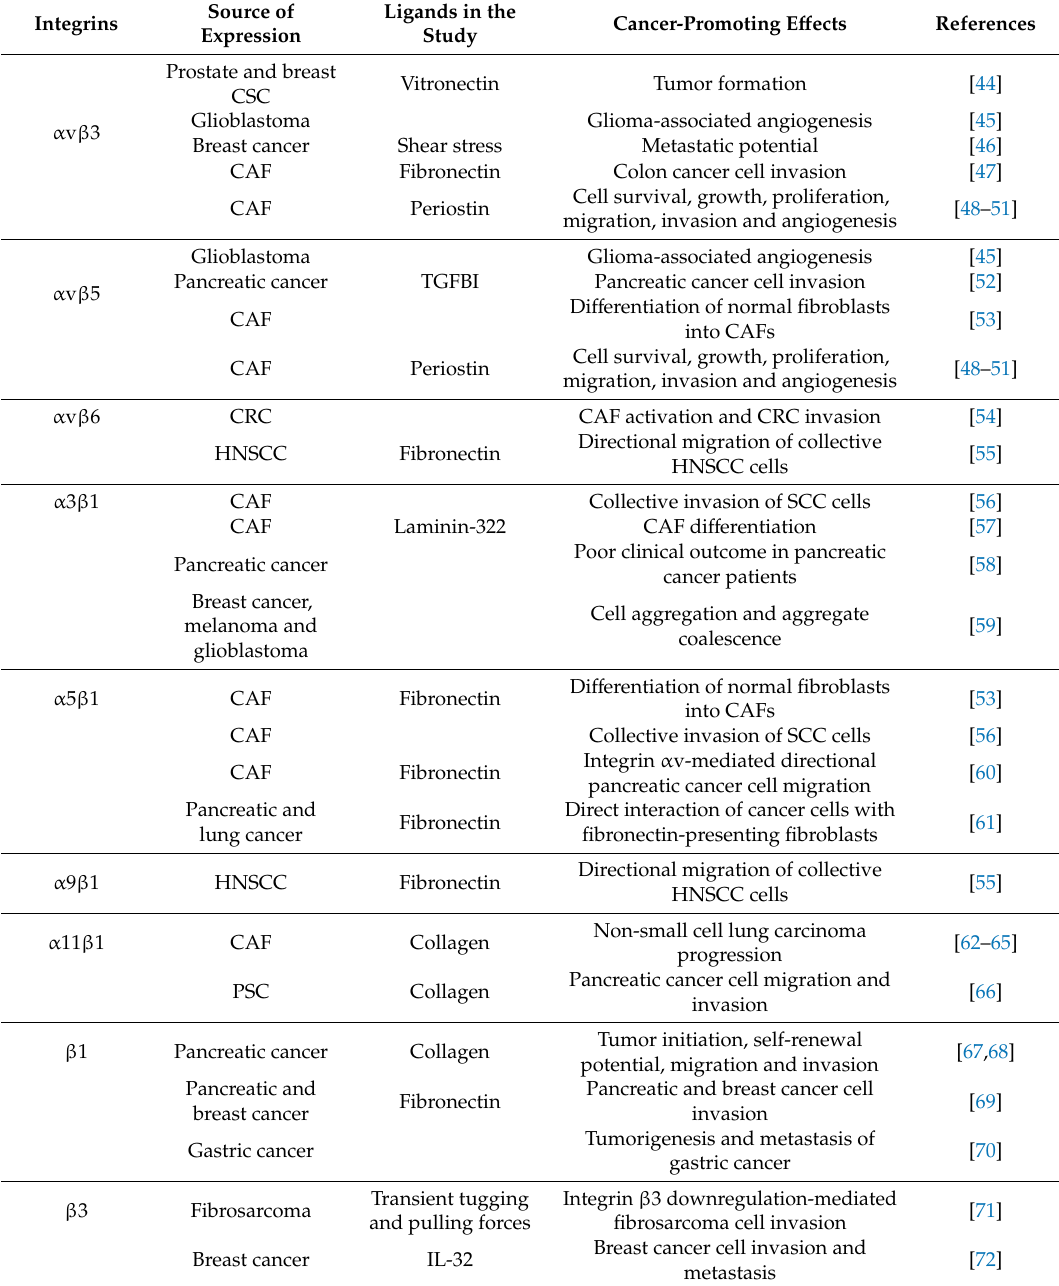
Table 1. Integrins in cancer